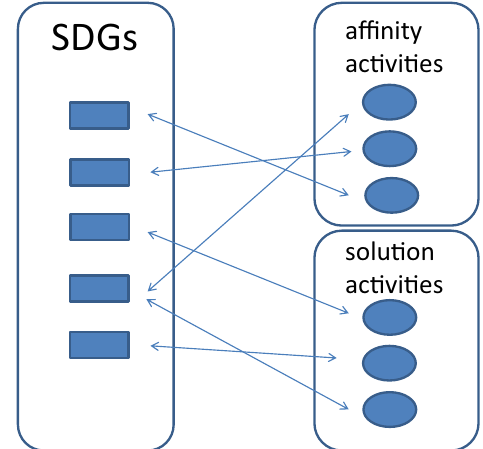
Fig. 6 Synthesize SDGs and